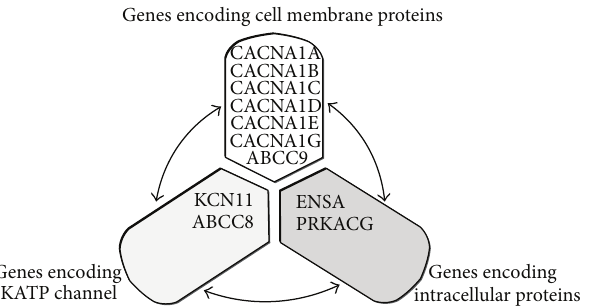
Figure 3: Cross-talk between the KCNJ11 gene and the other genes involved in the regulation of insulin secretion in pancreatic beta cells. KCNJ11 interacts with many genes, of which 10 are most prominent. KCNJ11 interacts with ABCC8 to produce the KATP channel, which transfers potassium ions across the beta cells. The KCNJ11 and ABCC8 genes interact with three groups of gene products at the cell membrane (white) and the intracellular (dark gray) levels. KATP: ATP-sensitive potassium channel; CACNA1A: calcium channel, voltage-dependent, P/Q type, alpha 1A